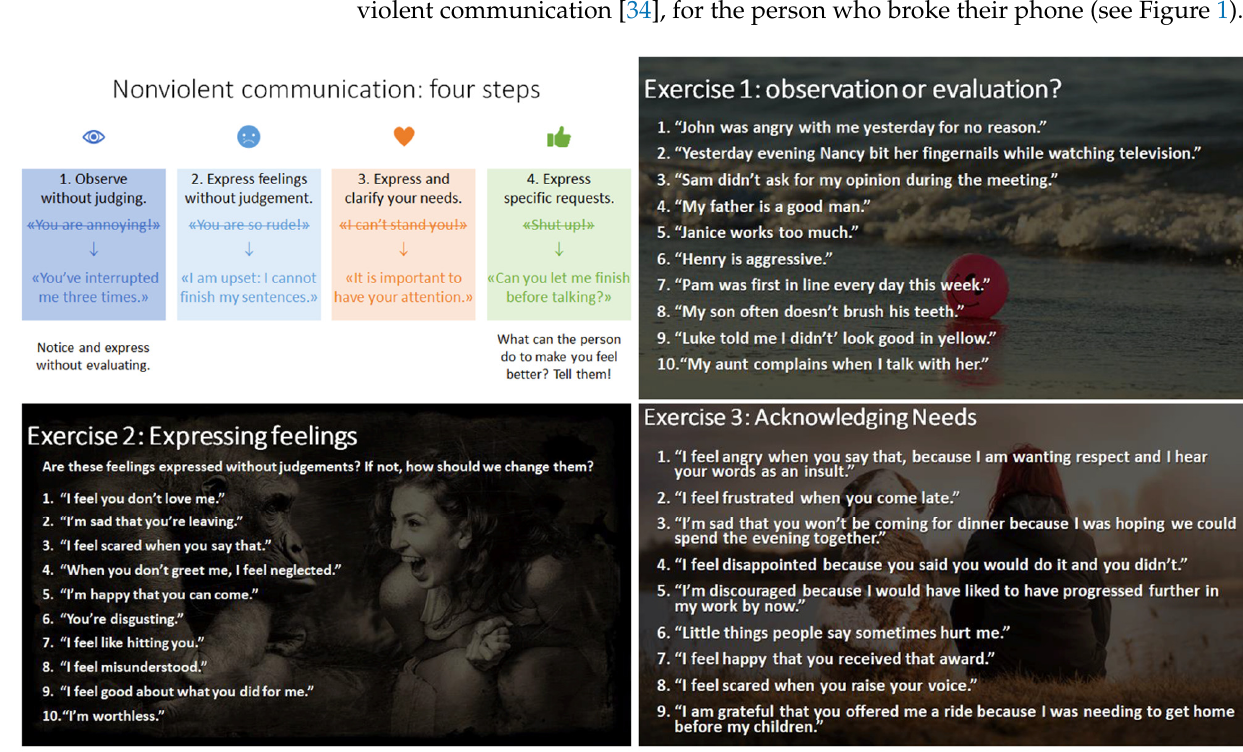
Figure 1. Examples proposed in a pedagogical session built for the Masters thesis of Marchetti and Reymond (adapted with permission from [35]). 2021, Marion Marchetti.